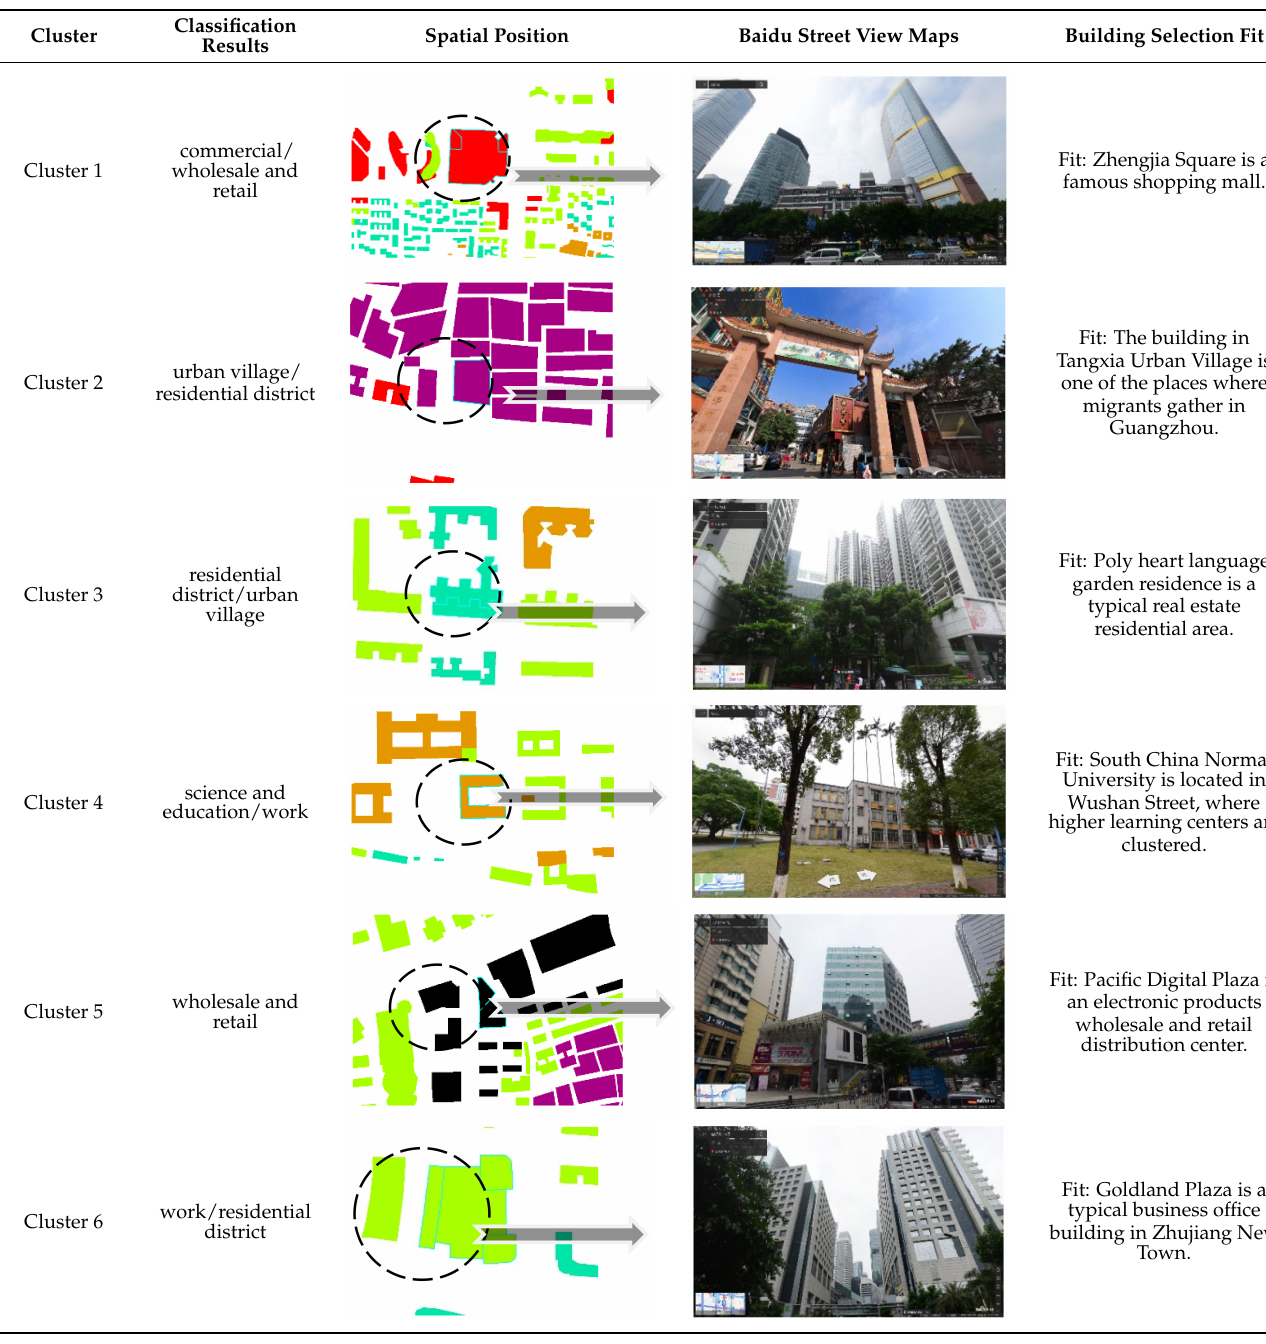
Table 3. Comparison analysis of clustering results and current situation of Baidu street view